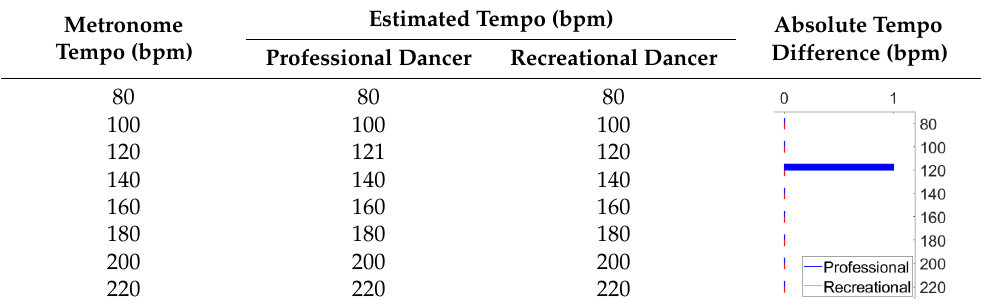
Table 1. Overall dance tempo estimation results. For all but one sequence, the estimated tempo matches perfectly the tempo dictated by the metronome. For the remaining sequence, i.e., the professional’s 120 bpm sequence, the absolute difference is 1 bpm, which is in the range of metronome beat onset stability.